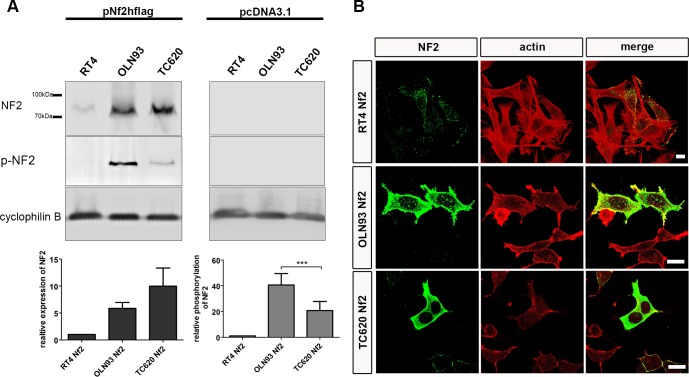
Expression of Merlin and phospho-Merlin in oligodendrocyte cell lines.RT4, OLN93 and TC620 cell lines were stably transfected with pcNF2hflag (Merlin) and pcDNA3.1 (control). Representative Western blots of gels loaded with 15 μg of total protein extracts are shown in A. The densitometric determination of Merlin and phospho-Merlin in the cell lines was performed by normalizing with cyclophilin B (mean ± SEM, n = 3, ***p < 0.001, Wilcoxon rank-sum test). Immunofluorescent staining of Merlin and phalloidin staining of actin in Nf2 stably transfected cell lines demonstrates the preferred localization of Merlin in the cytoplasm (B). Single confocal planes of transfected cells are shown using the same microscope parameters. Scale bars: 10μm.